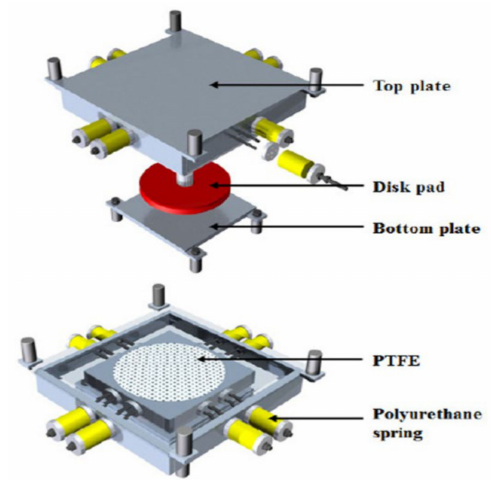
Figure 1. Configuration of resilient-friction base isolator system.